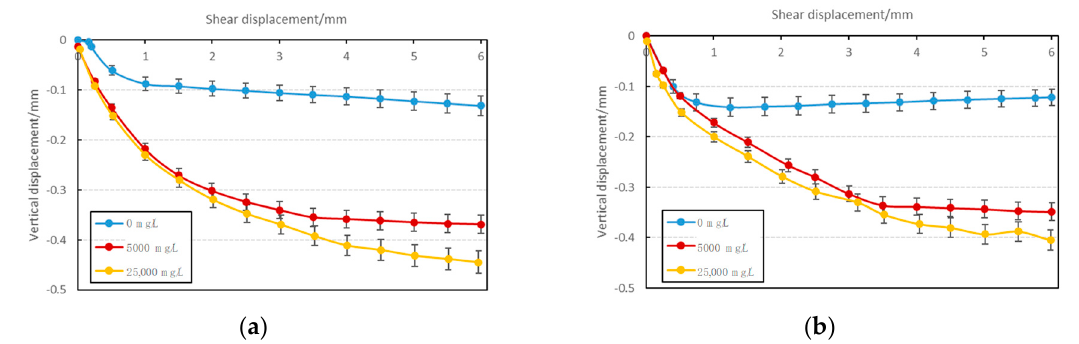
Figure 7. Vertical displacement vs. shear displacement curves of the FR-CPB / rock interface (treated for 1 day; normal stress of 50 kPa). ( a ) CPB made with 0% fibers; ( b ) CPB made with 0.3% fibers.